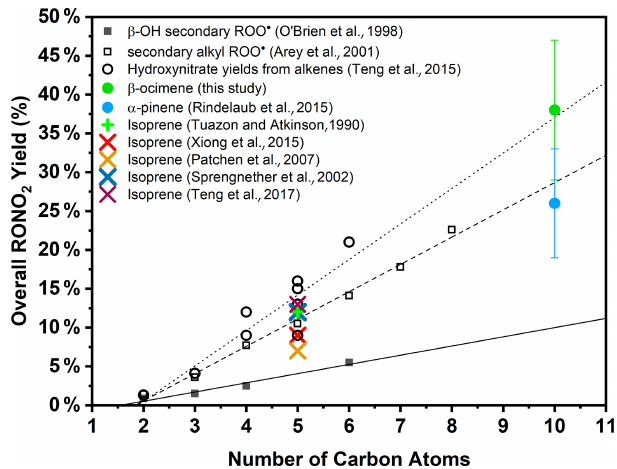
Figure 4. RONO 2 yield vs. size for alkyl peroxy radicals. Trend lines are representative for the data sets investigated in O’Brien et al. (1998) ( β -hydroxy nitrates from β -hydroxyperoxy radicals), Arey et al. (2001) (alkyl nitrates from secondary alkyl peroxy rad- icals, alkanes), and Teng et al. (2015) (absolute hydroxy nitrate yields from